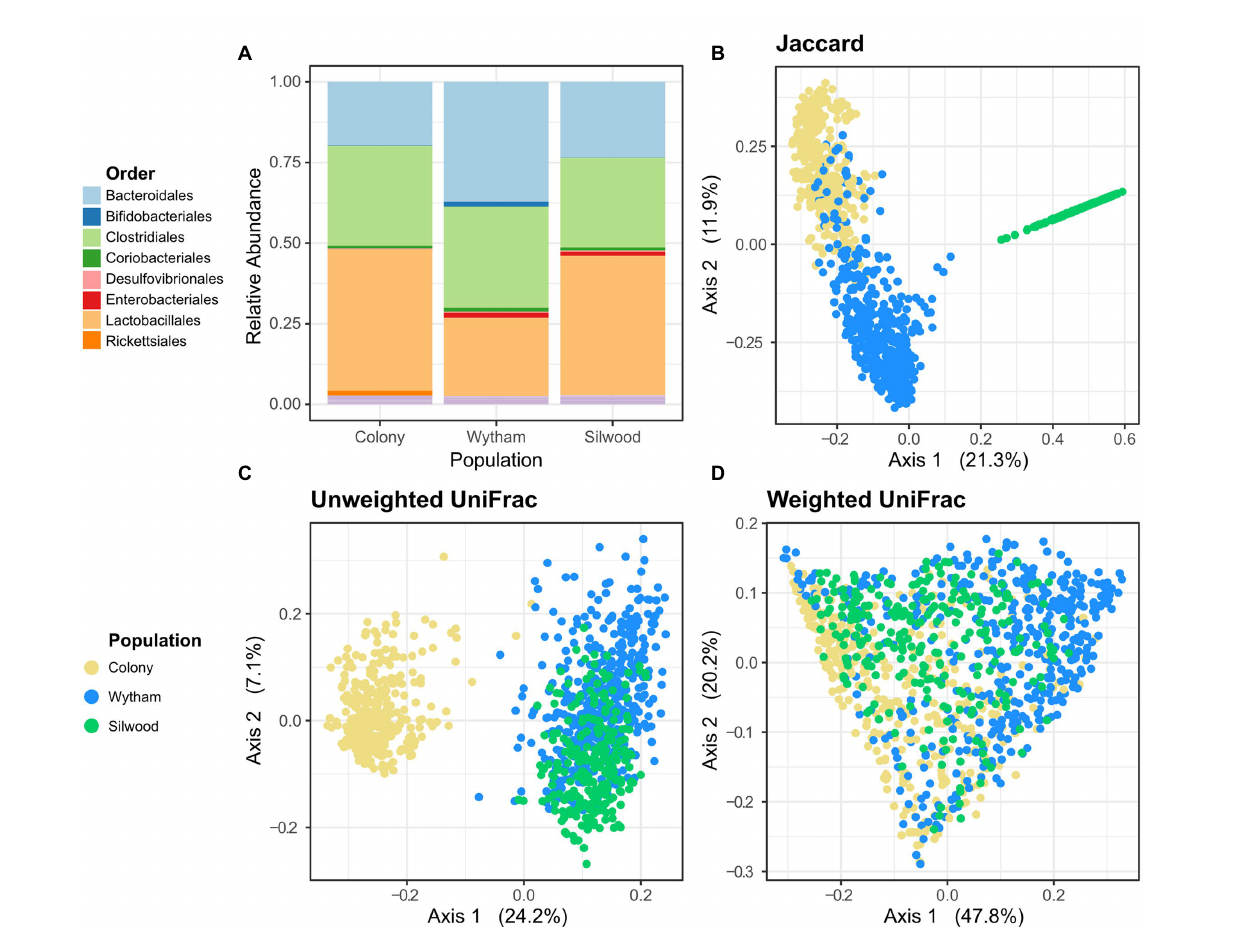
FIGURE 1 | Gut microbiota composition across populations of wood mice. (A) Comparison of microbiota composition at the Order level in faecal samples from a captive colony ( n = 351) and two wild populations, Wytham ( n = 448) and Silwood ( n = 253). Read abundances were summed across samples per population and their relative proportions are coloured by bacterial Order. Samples from all populations were used in principal coordinates analysis based on (B) Jaccard, (C) Uniweighted UniFrac, and (D) Weighted UniFrac